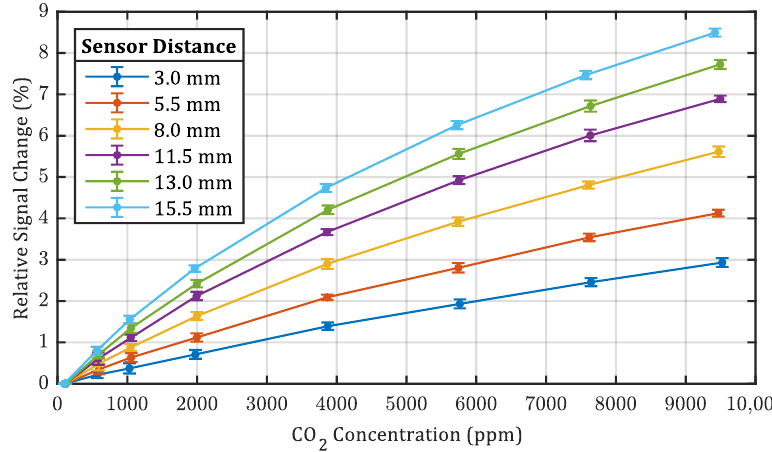
Figure 6. Signal response of six different absorption path distances ranging from 3.0mm to 15.5mm at different CO 2 concentrations, relative to the the lowest reachable concentration. Error bars represent standard deviation.